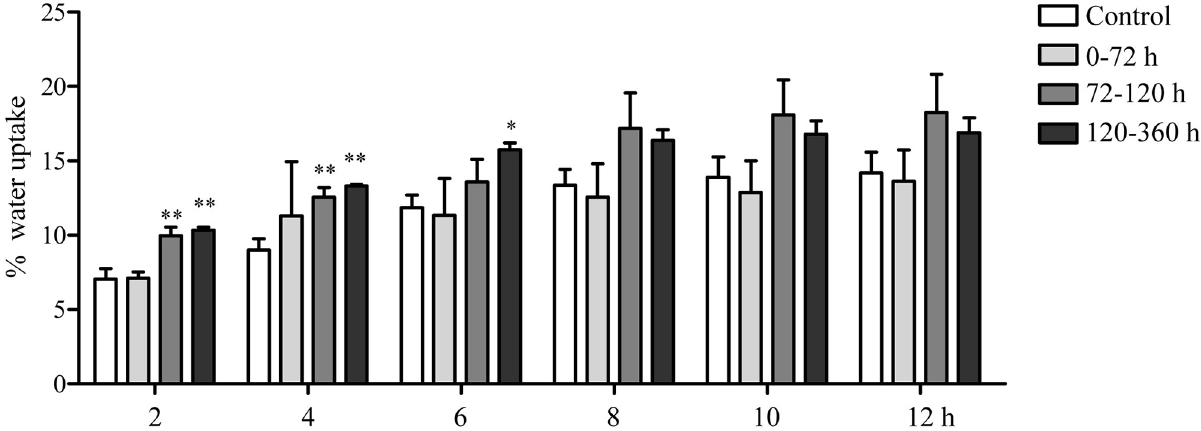
Fig 6. Effect of the DRT on C . spinosa seed water uptake. Water uptake of C . spinosa seeds with different DRTs. The data were from 3 independent experiments and were analyzed by ANOVA. � p < 0.05; �� p < 0.01 compared to the control group.